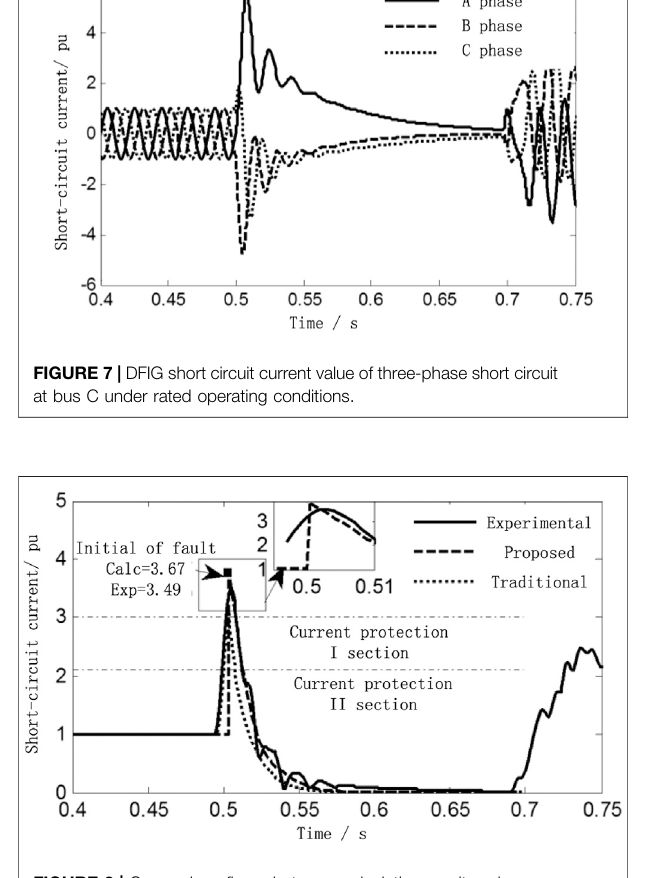
Frontiers in Energy Research |